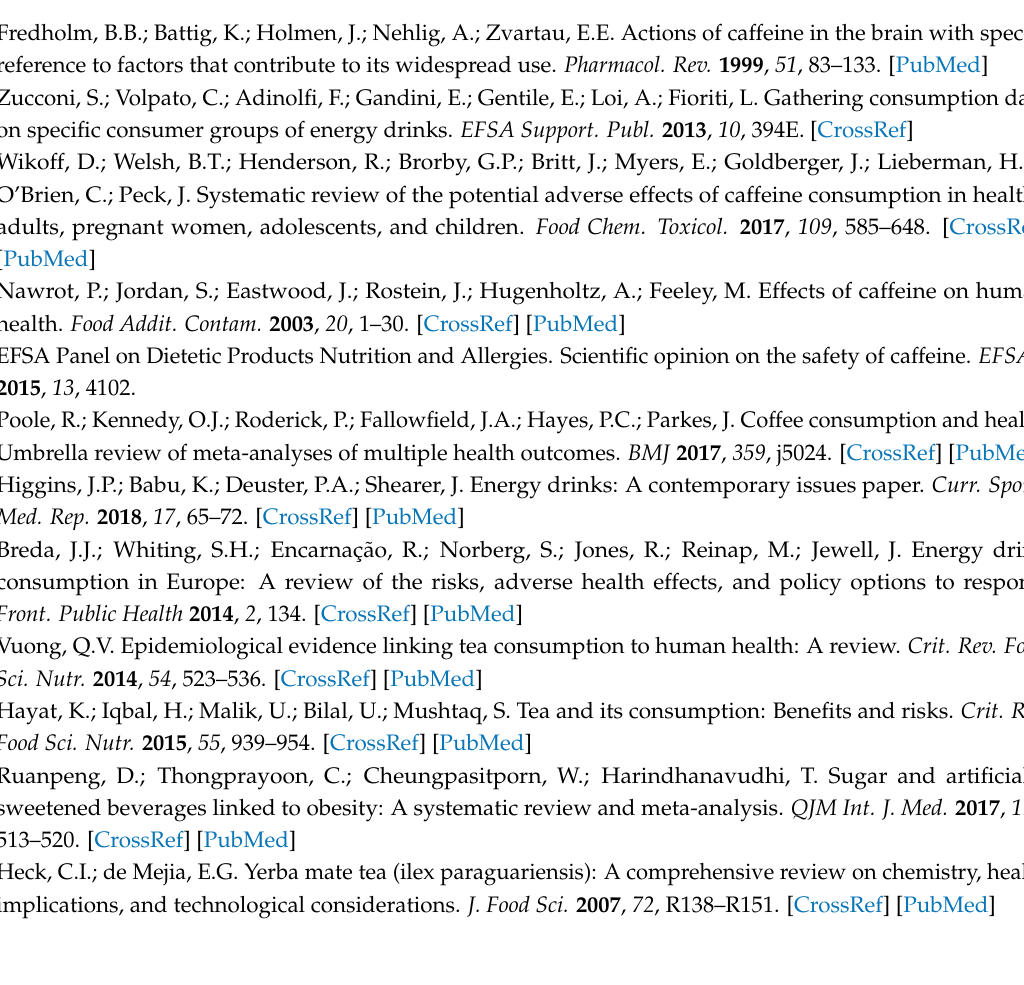
s1, Figure S1: Data Collection Strategy for Dietary Caffeine Guidelines; Table S1: Country Specific Guidelines Pertaining to Dietary